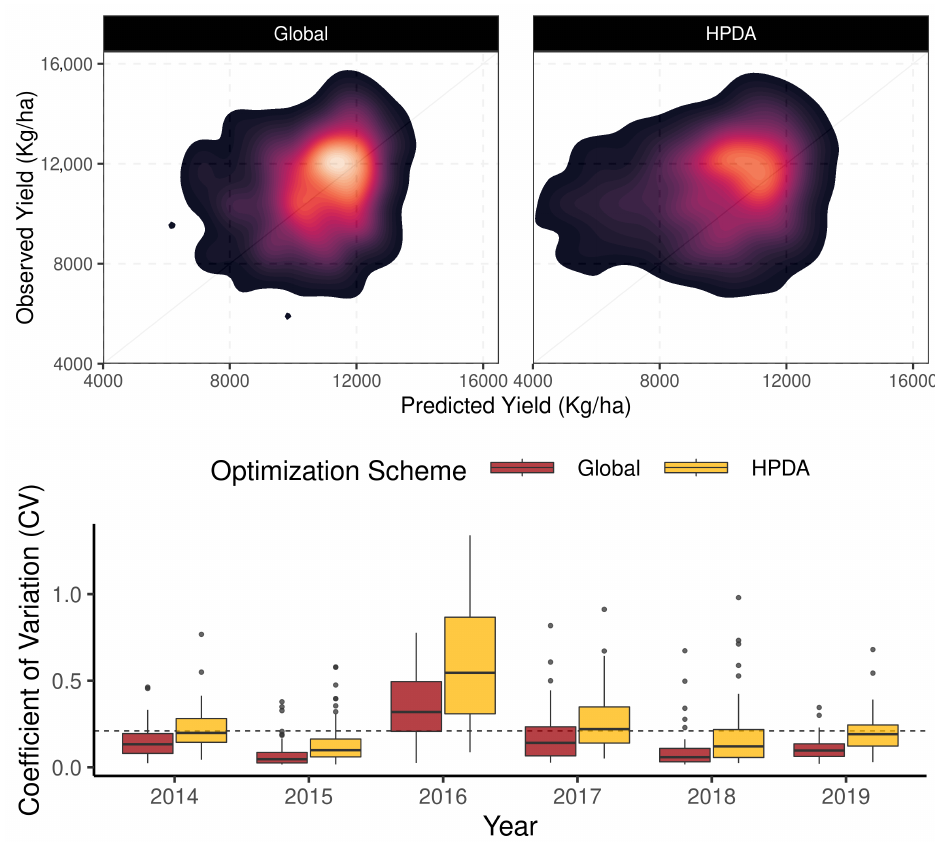
Figure 9. Density plots comparing yield estimates for out of sample sites ( top ), and yield variability ( bottom ) for global and HPDA optimization